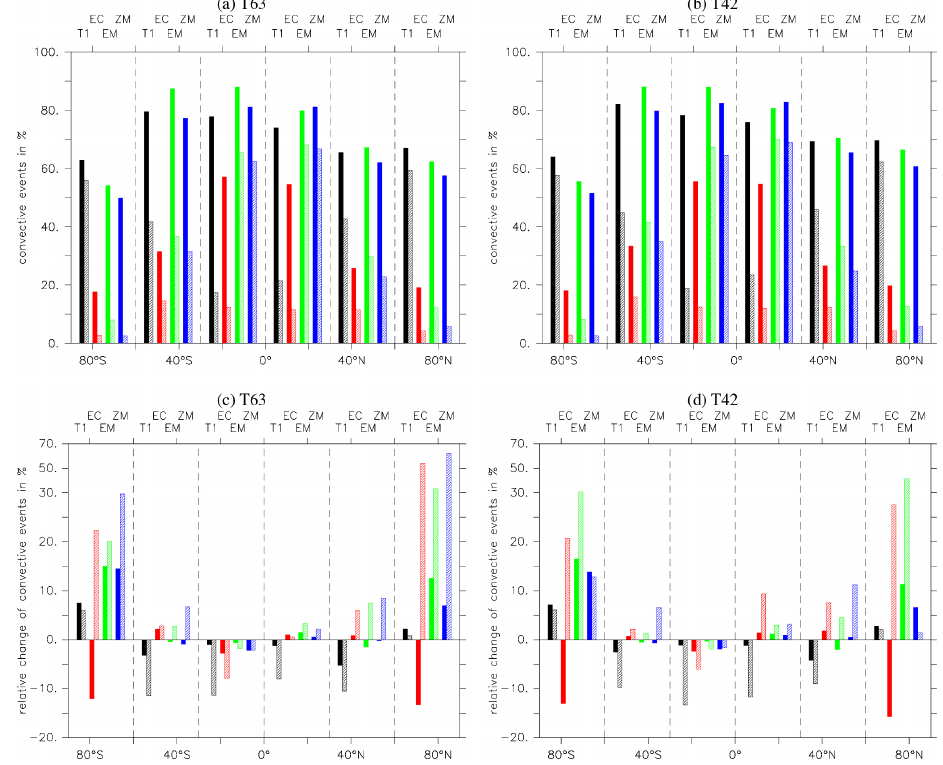
Figure 4. Zonal average activation of the convection scheme in %. Each bar represents an average over 30 ◦ latitude (90 ◦ S to 60 ◦ S, 60 ◦ S to 30 ◦ S, etc.) for all simulations indicated in the top row of the graphs. The filled bars show the absolute activation of the convection parameterisation and the dashed bars count only deep convective events (and midlevel for T1 and EC). The two upper panels display the activation in the reference simulations and the lower ones the relative difference of the 2 × CO2 against the REF